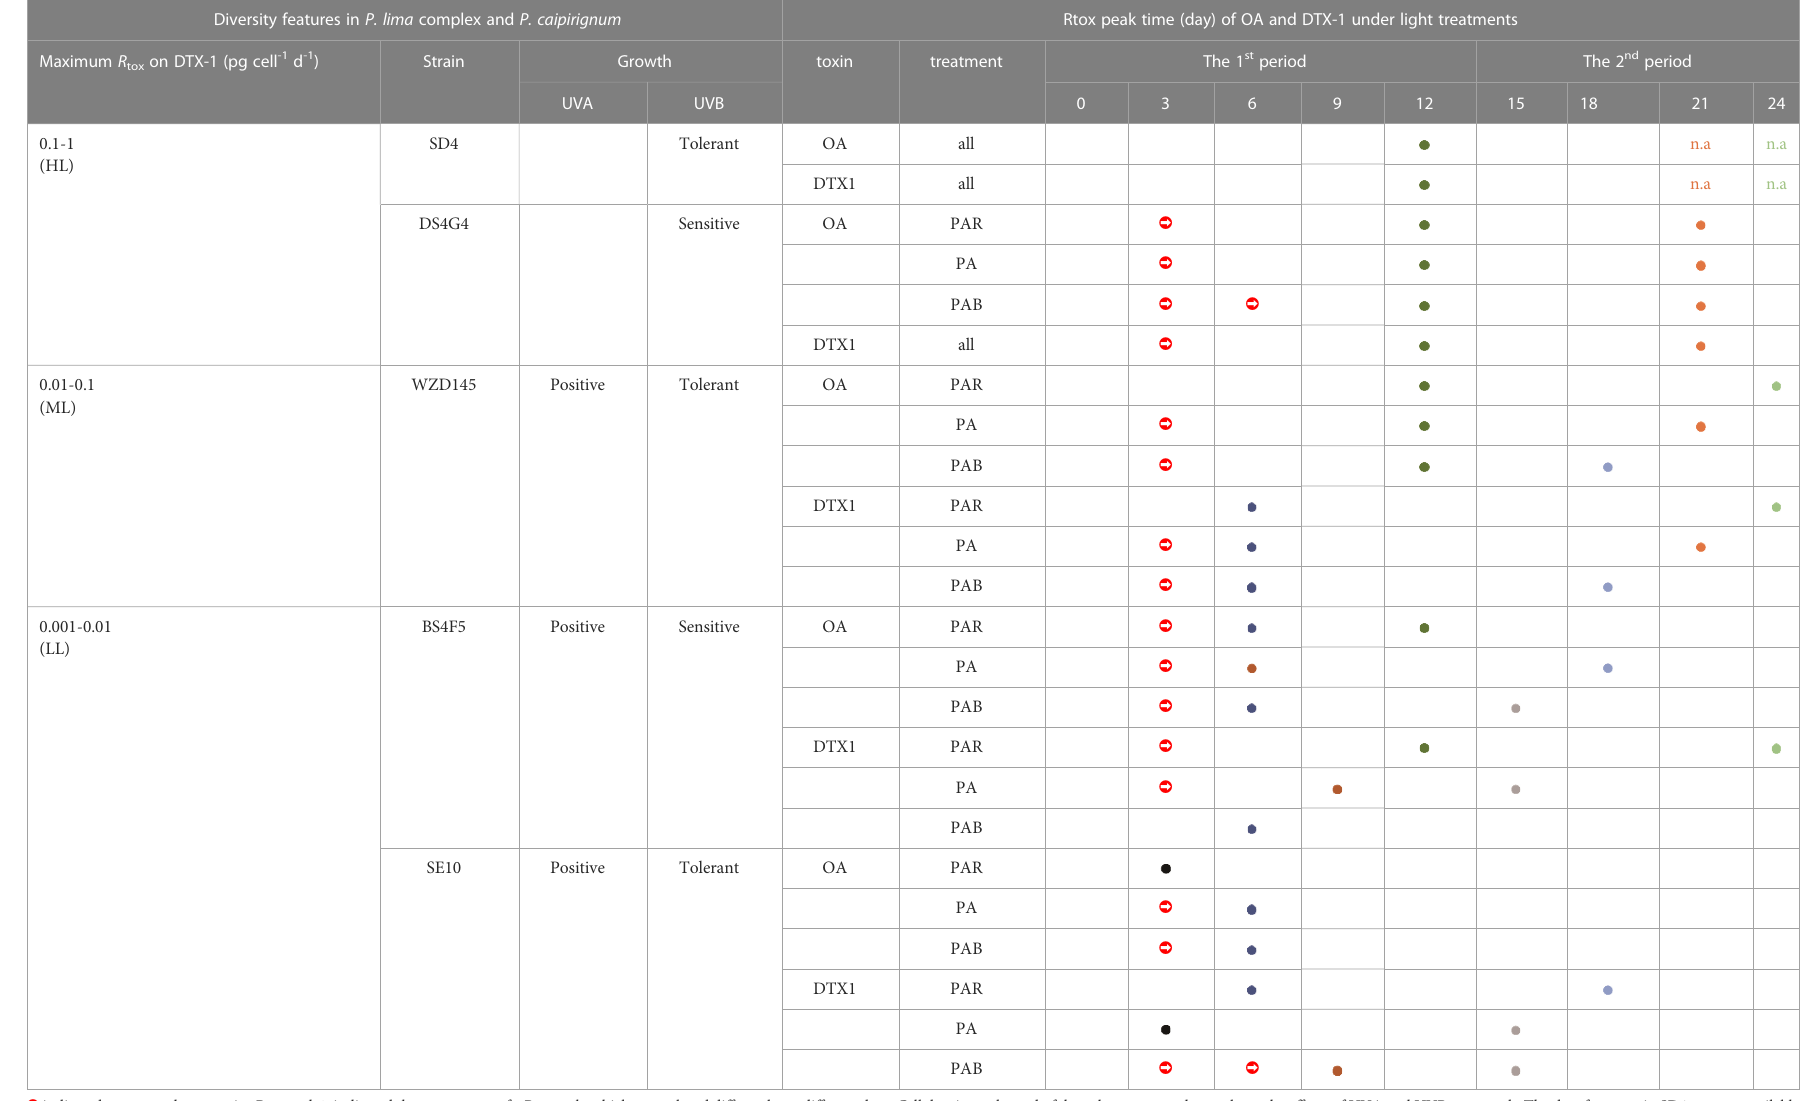
TABLE 2 Different DTX-1 production capacities, light responses, and toxin production ( R tox ) peak times under light treatments in fi ve strains of P. lima complex and P. caipirignum (strain SE10). Diversity features in P. lima complex and P. caipirignum